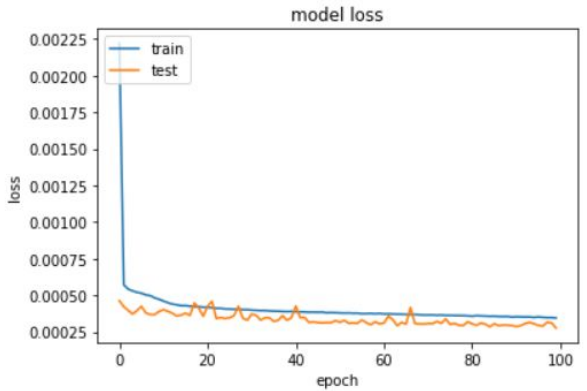
( b ) Figure 6. Model fitting test and train loss minimization for ( a ) Multi-headed CNN ( b ) and Simple CNN structure. Figure 7 represents the loss value minimization for the CNN-LSTM architecture. In comparison with Figure 6a and6b, it can be observed that the model fitting takes slightly longer, yet it is completed